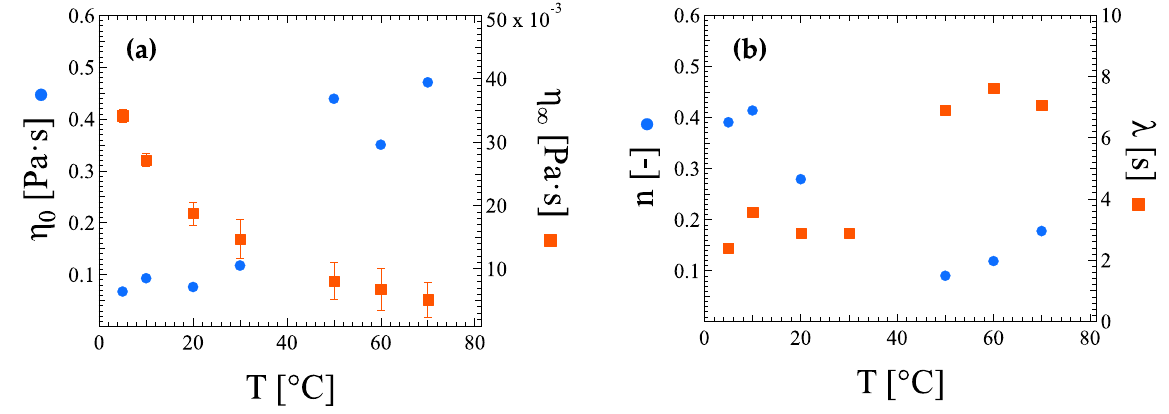
Figure 6. Carreau–Yasuda model fitting parameters with error bars of ( a ) asymptotic viscosities at zero η 0 and infinity η ∞ shear rates, and ( b ) flow behavior, or power, index n and flow consistency